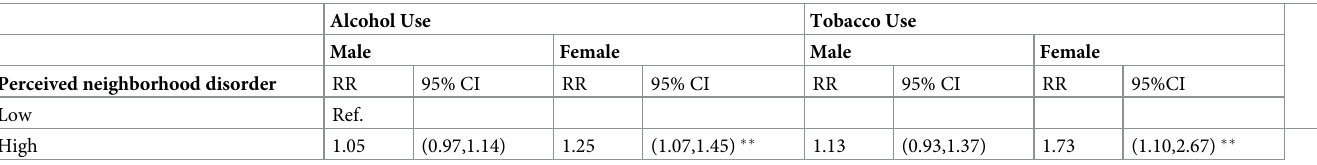
Table 3. Adjusted relative risks and 95% confidence intervals between perceived neighborhood disorder and current alcohol and smoking use stratified by sex 1